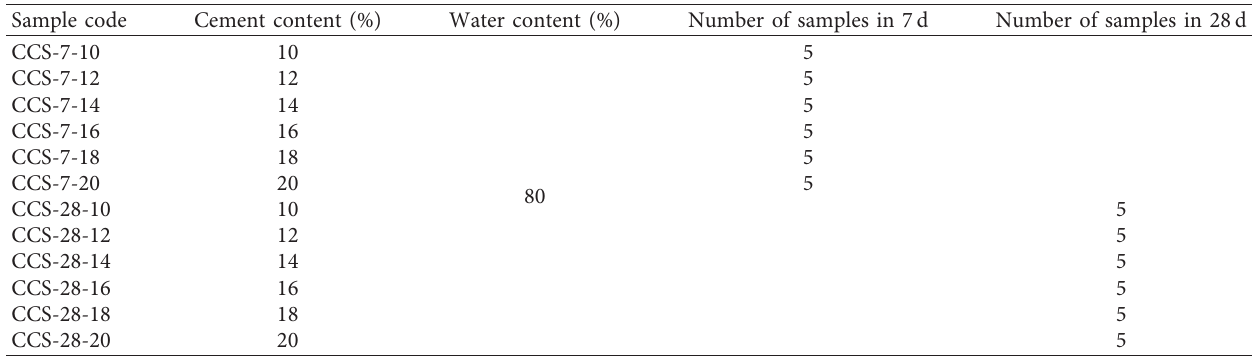
Table 4: Sample design scheme of coastal cement soil (CCS).